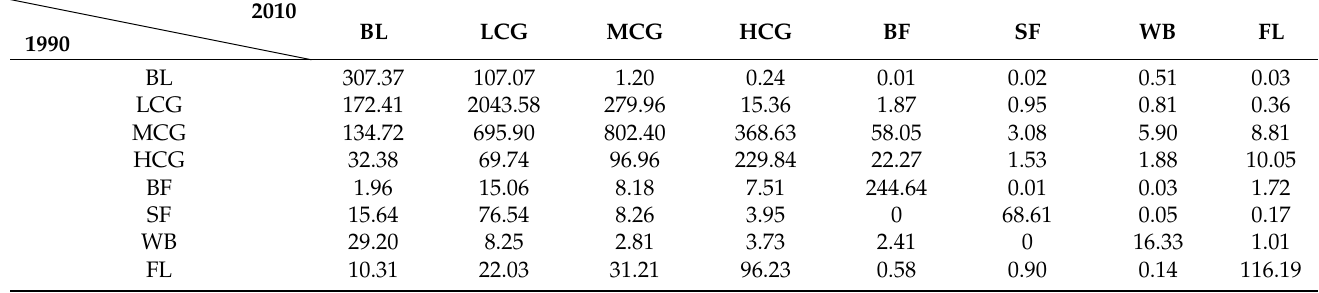
Table A6. Ecosystem service value changes from 1990 to 2010 (106 yuan).